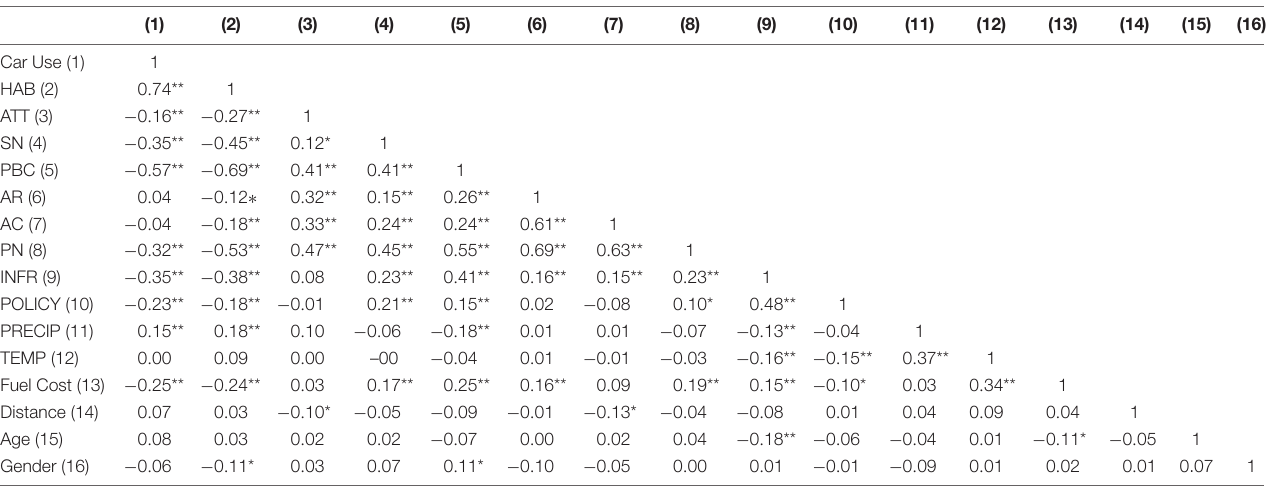
TABLE 3 | Intercorrelations between the variables included in the model.